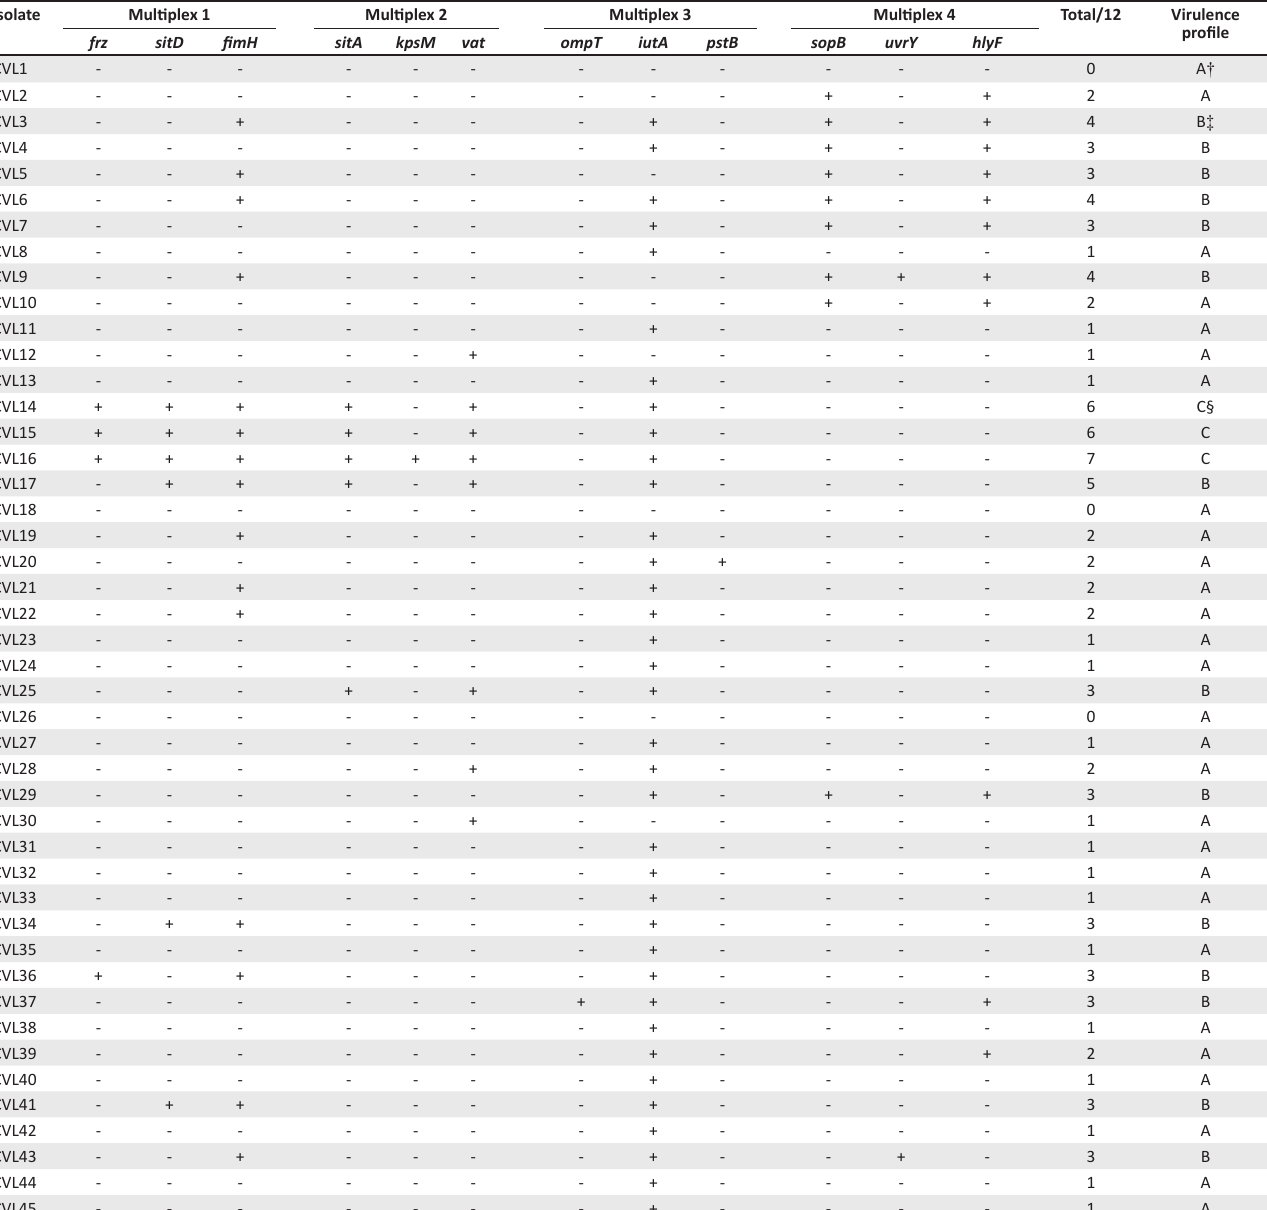
TABLE 3: Presence or absence of expected amplicons and virulence profiles of avian pathogenic Escherichia coli isolates.